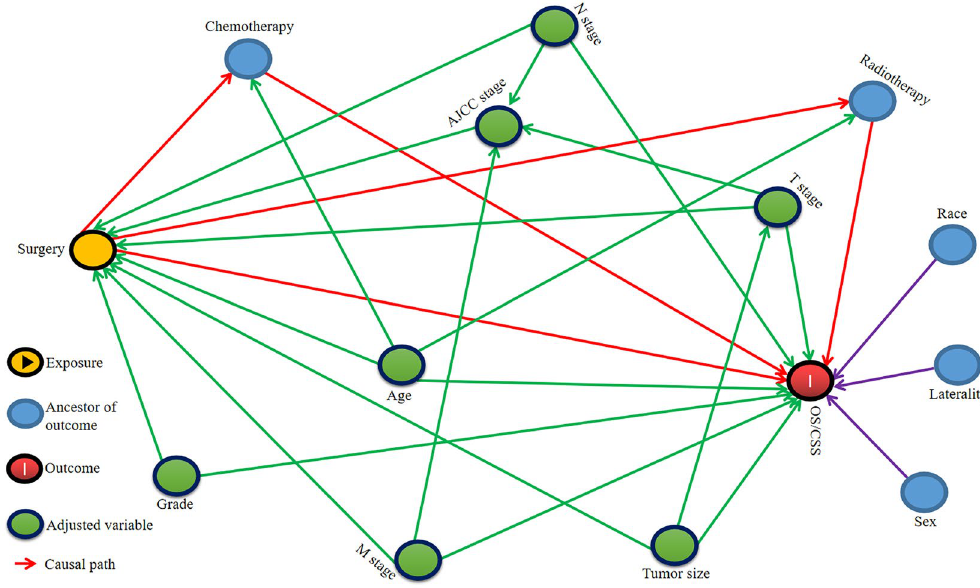
Figure 3. Directed Acyclic Graphs (DAG) show the impact of surgery on Overall Survival (OS) and Cancer- specific survival (CSS).